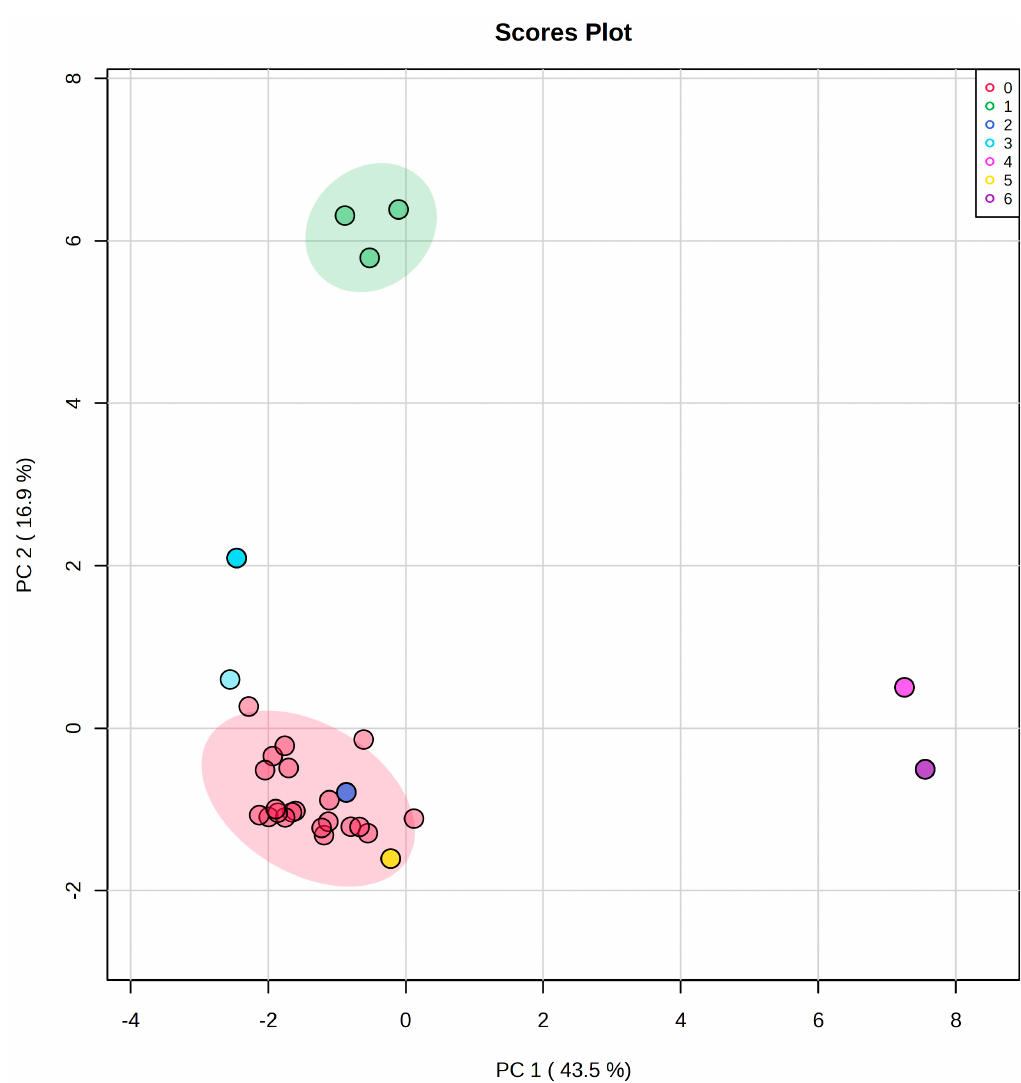
Figure 1. A PCA scores plot based on FTIR spectra obtained from two distilleries. Shaded areas are the 95% confidence regions.